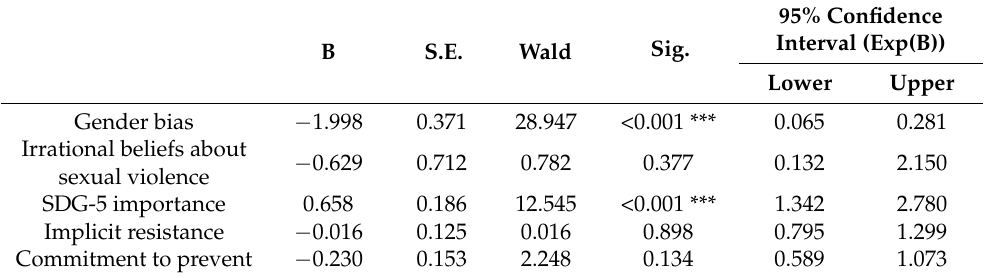
Table 6. Gender differences.